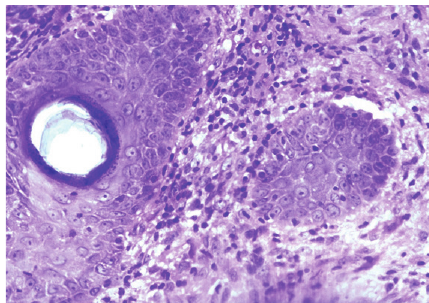
Figure 4: Biopsy shows well-formed granulomas with epithelioid cells and Langhans giant cells surrounded by chronic inflammatory cells and central necrosis [H and E